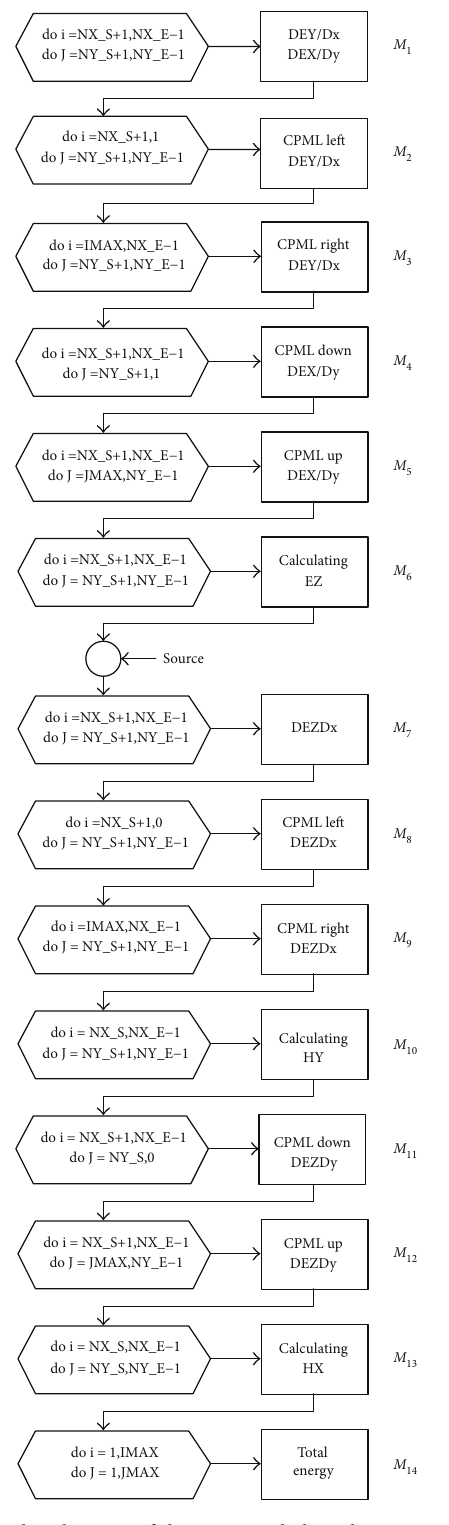
Figure 4: Flux diagram of the numerical algorithm using memory variables only in the absorption region. The cycles are numbered as M 1 ⋯ M 14 .